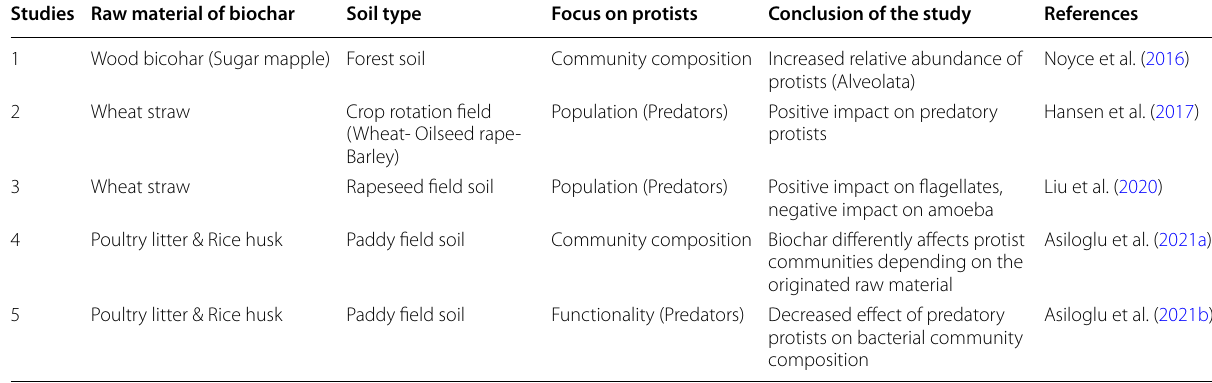
Table 1 Studies on biochar-protist interaction Studies Raw material of